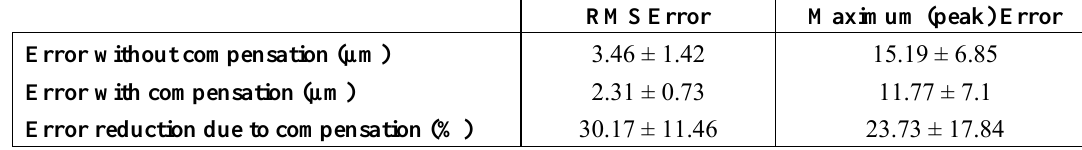
Table 3. Mean and standard deviation of RMS errors and maximum (peak) errors of estimation of physiological tremor signals from ten subjects with and without proposed compensation method.